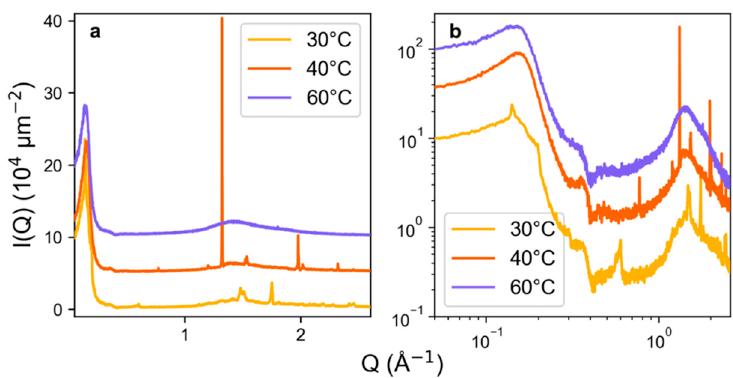
Figure 5. Normalised and desmeared SWAXS patterns for 40 wt.% of C 12 TAB in ethaline DES as a function of temperature, shown as a linear plot ( a ) and a log-log plot ( b ) To aid visibility, SWAXS data are arbitrarily offset in ( a ) by I(Q)+5 (40 °C) and I(Q)+10 (60 °C), and in ( b ) 5·I(Q) (40 °C) and 10·I(Q) (60 °C).